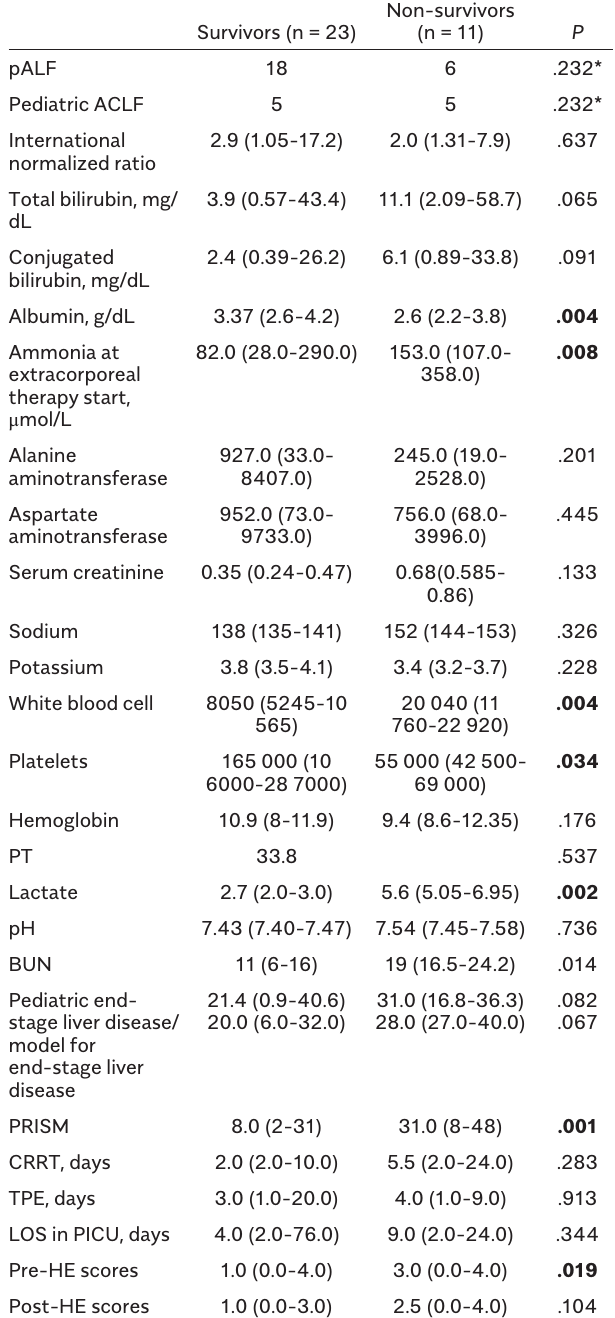
Table 2. Effect of Extracorporeal Therapy as a Bridge to Transplant and Overall